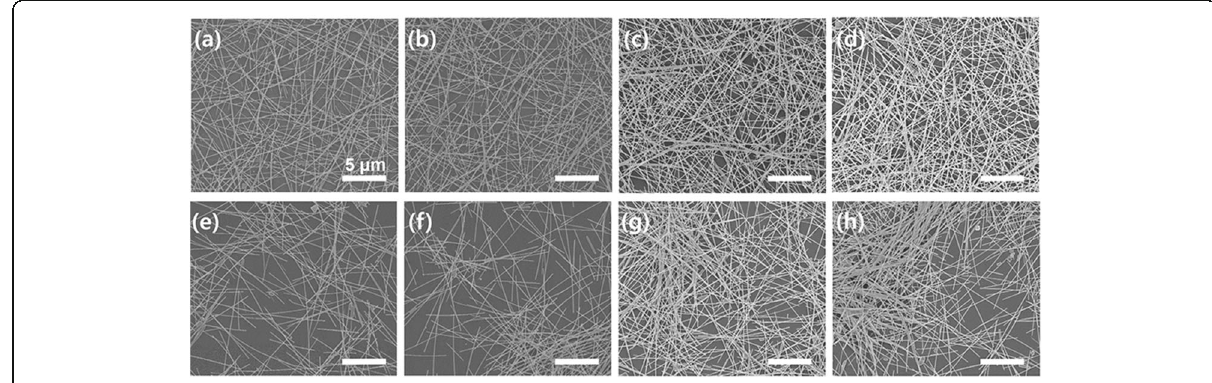
Fig. 2 FE-SEM images of AgNW films with different deposition numbers and prepared by different coating methods. a – d The cross-AgNW films with different surface concentrations of AgNWs. e – h The drop-casted AgNW films with corresponding AgNW concentrations. Surface density of AgNWs on Au substrate: a , e 4.7 μ g/cm 2 , b , f 5.9 μ g/cm 2 , c , g 8.3 μ g/cm 2 , and d , h 10.6 μ g/cm